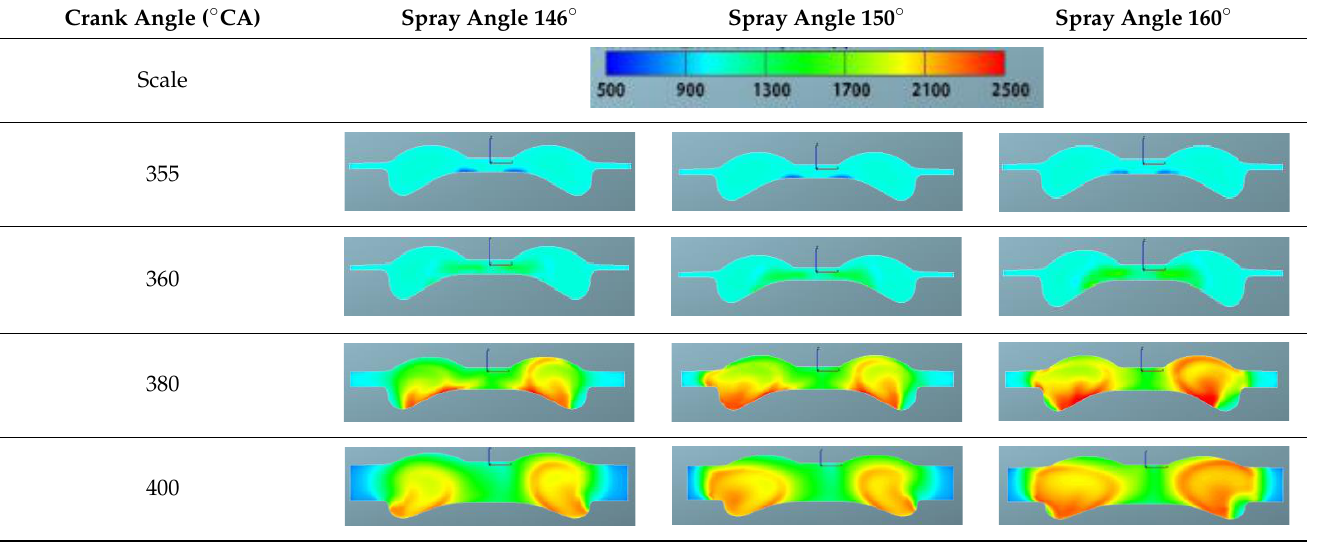
Table 13. Comparison of the temperature field for three different spray angles in F1 combustion